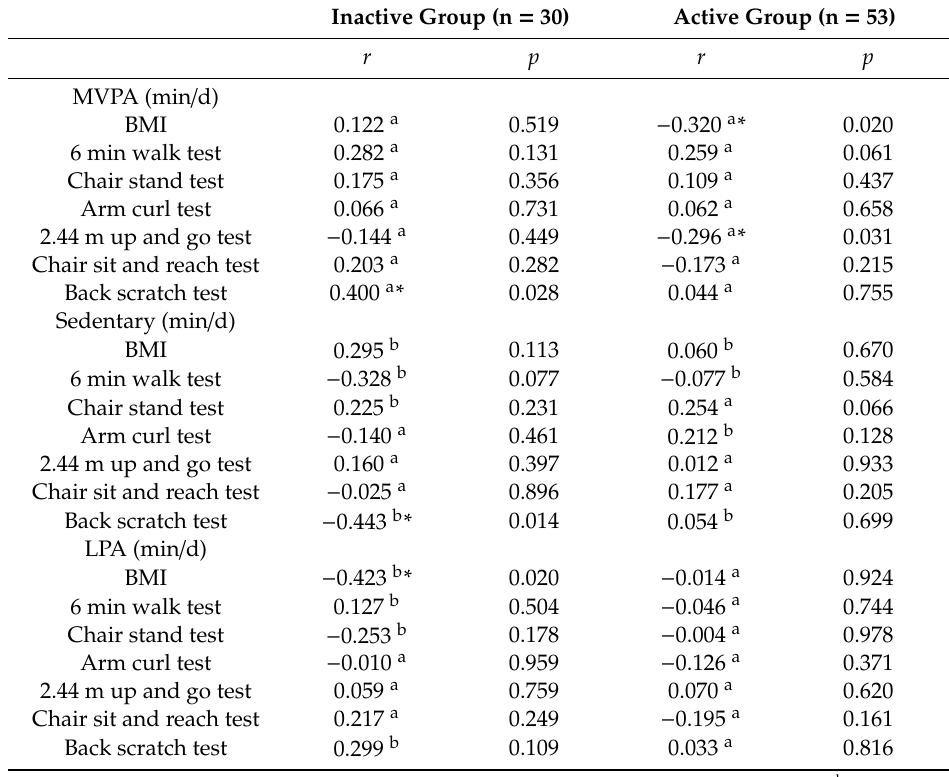
Table 3. Bivariate correlation between sedentary time and physical activity levels with physical fitness on older adults who fulfilled global recommendations on physical activity for health (active group) and on those who did not fulfil these recommendations (inactive